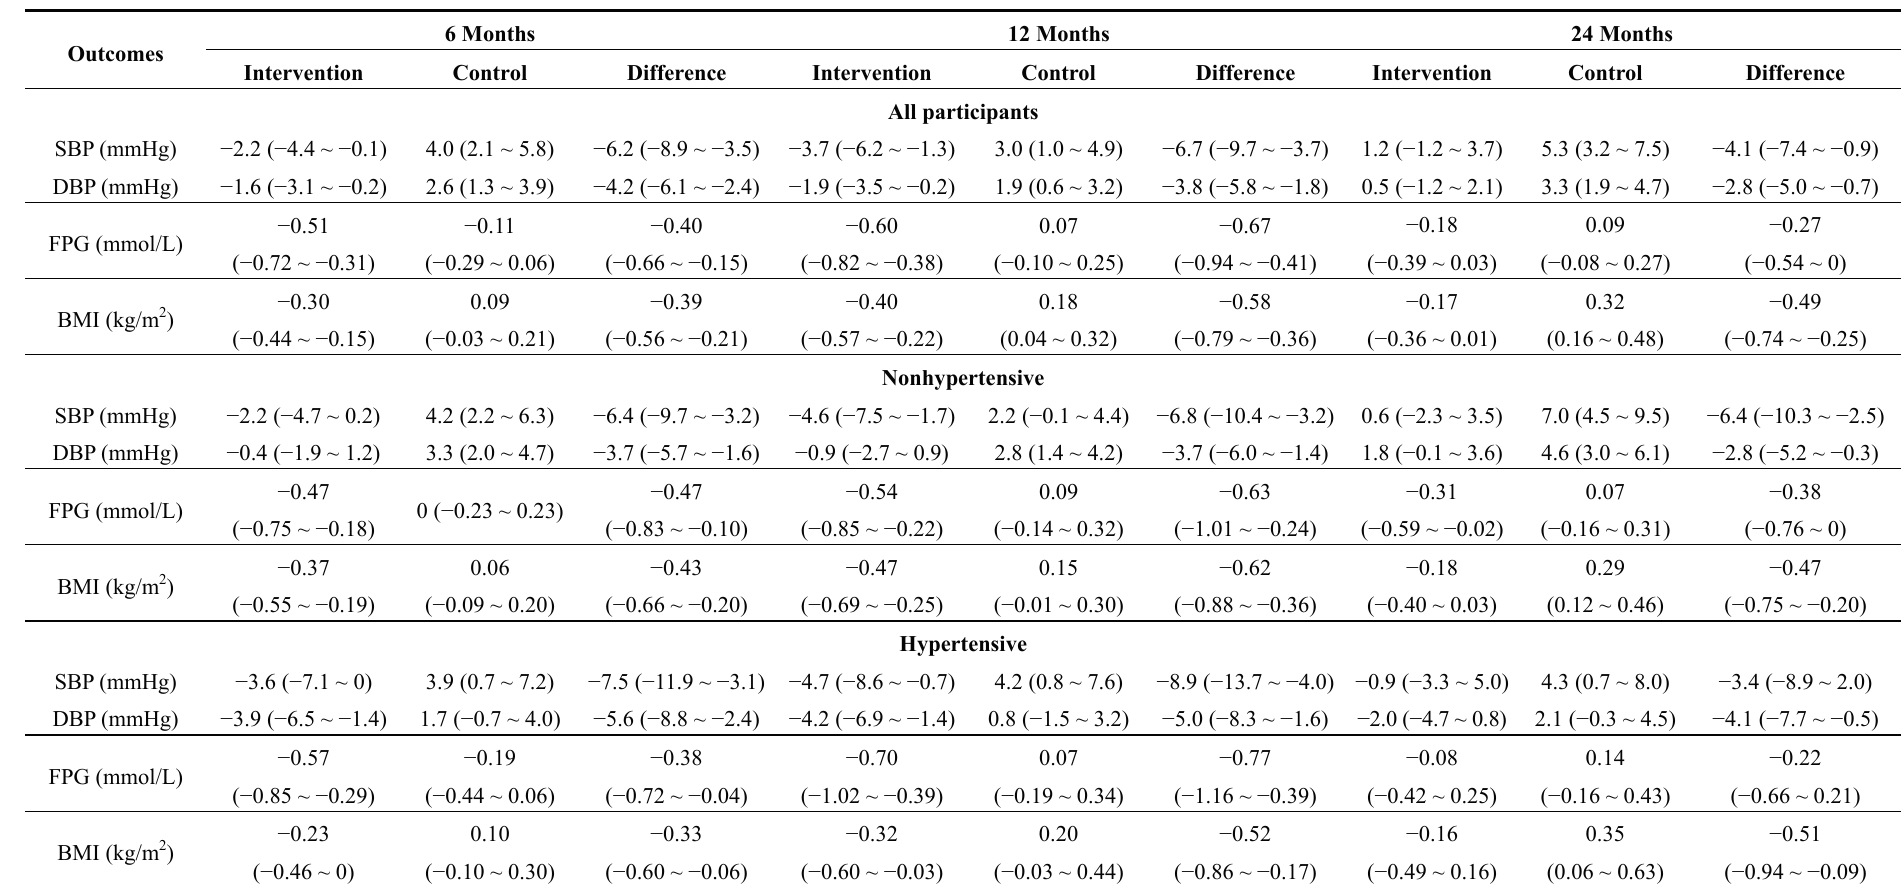
Table A1. Sensitivity analyses based on the completion population *